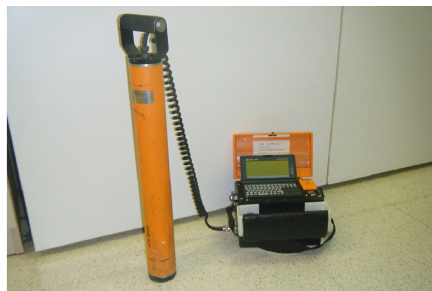
Figure 1: Picture of the portable gamma-ray spectrometer GF Instruments model GRS-2000 used for field measurements in this work. On the left side, the probe with the detector can be seen, and on the right side, the computer system with electric supply can be seen.